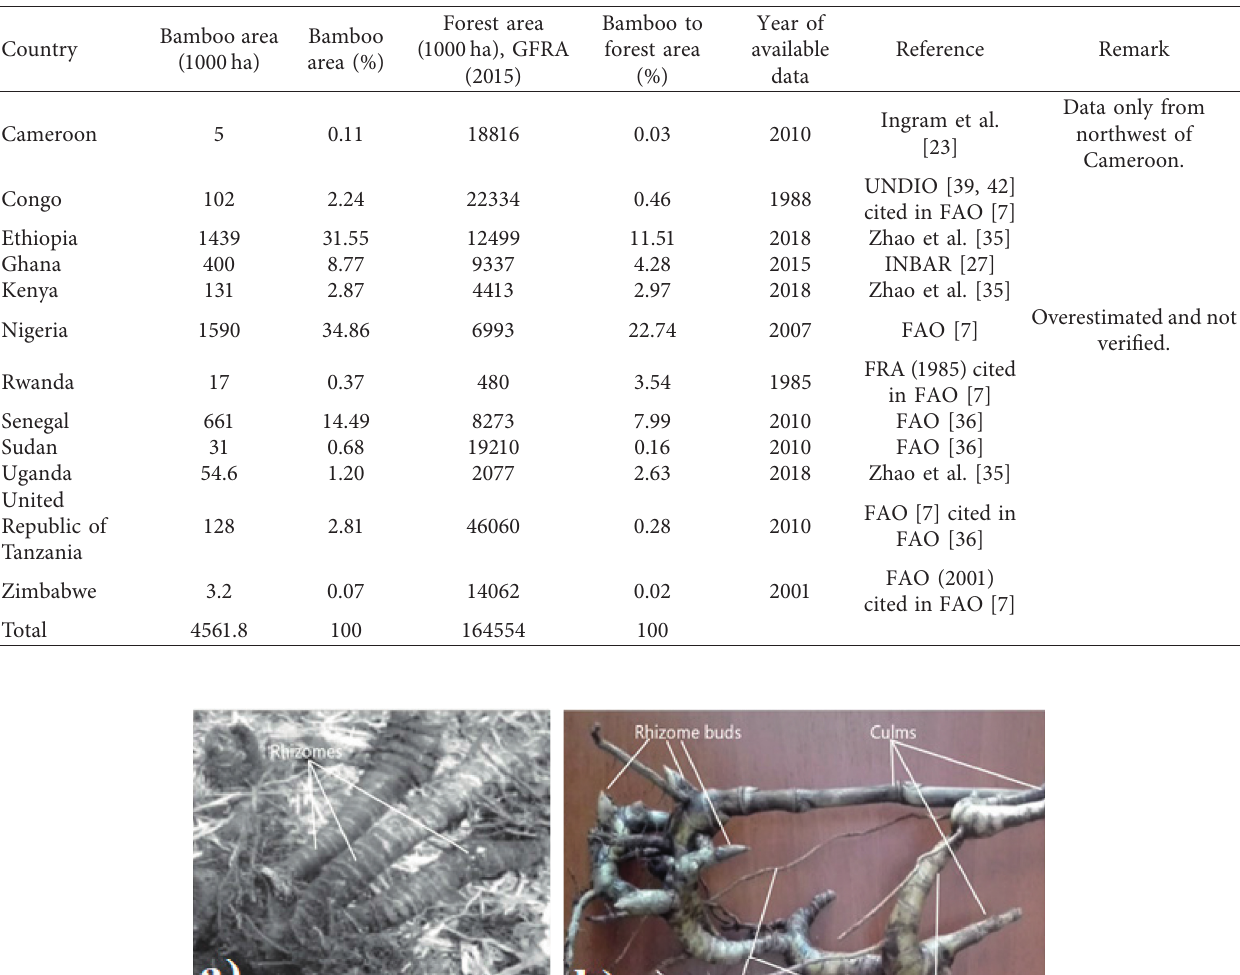
Table 6: Status and potential of bamboo resource in the African region.